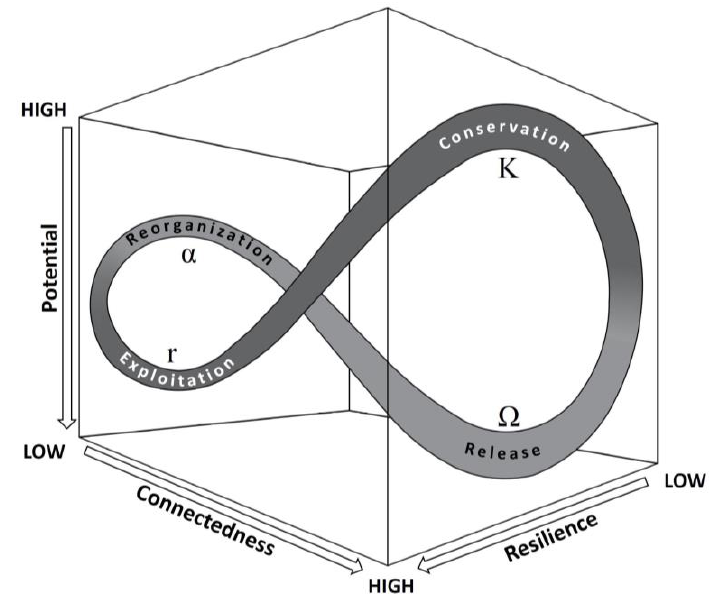
Figure 1. The adaptive cycle heuristic model.